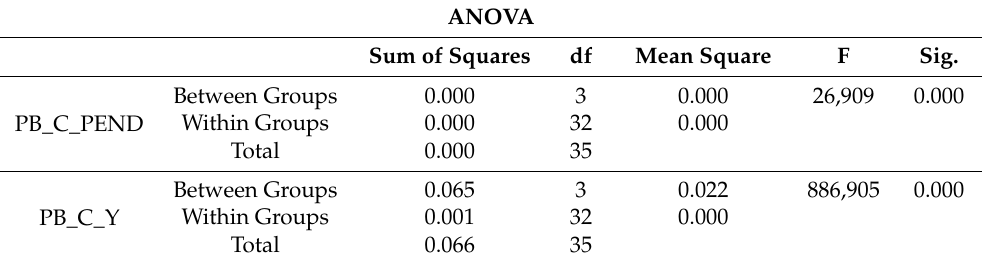
Table 3. Analysis of variance.